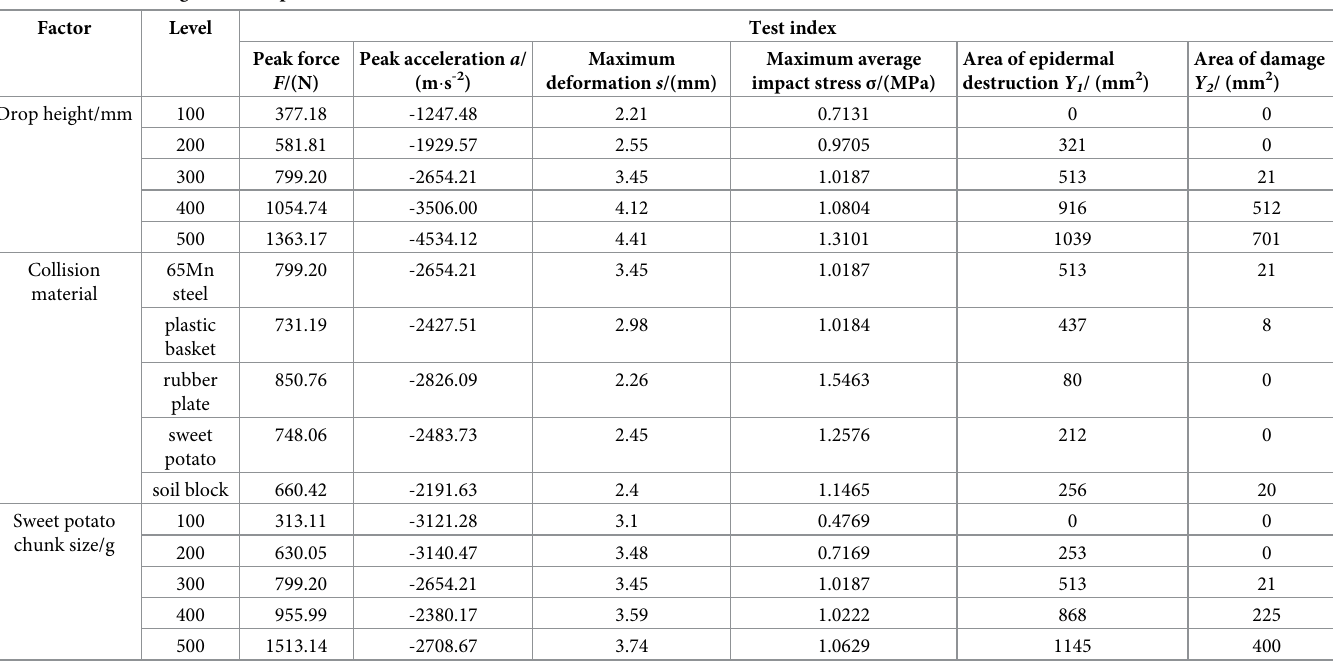
Table 3. Results of single factor experiment.